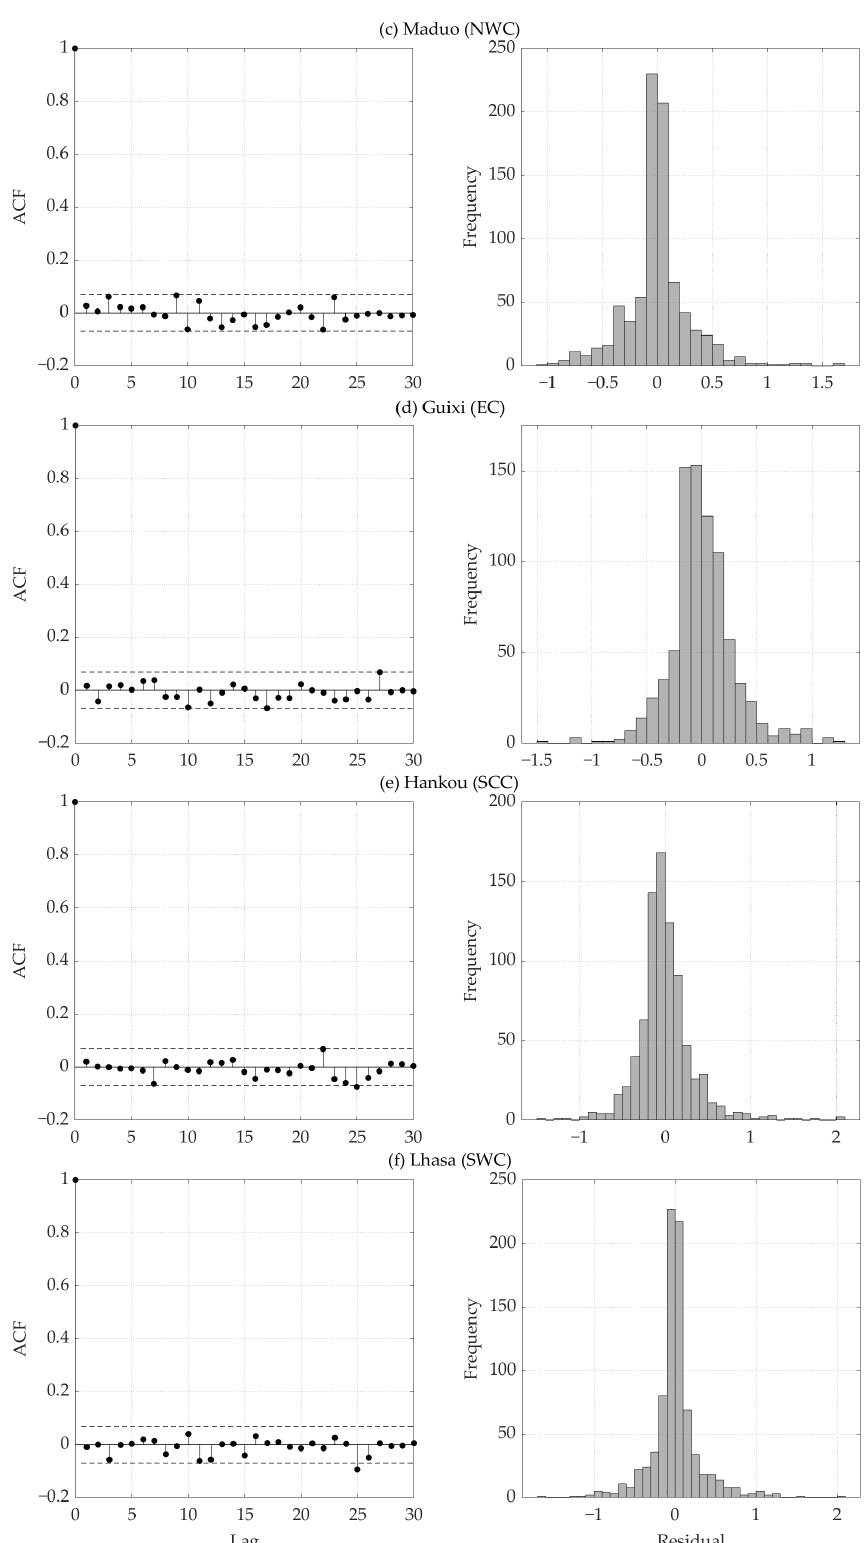
Figure A2. ACF plots (left column) and statistical histograms (right column) of the residuals between the SPEI-12 and model fit value at the stations: ( a ) Harbin (NEC), ( b ) Boketu (NC), ( c ) Maduo (NWC), ( d ) Guixi (EC), ( e ) Hankou (SCC), and ( f ) Lhasa (SWC). The ACF plots indicate that the residuals are unautocorrelated; the histograms indicate that the residuals conform to a normal